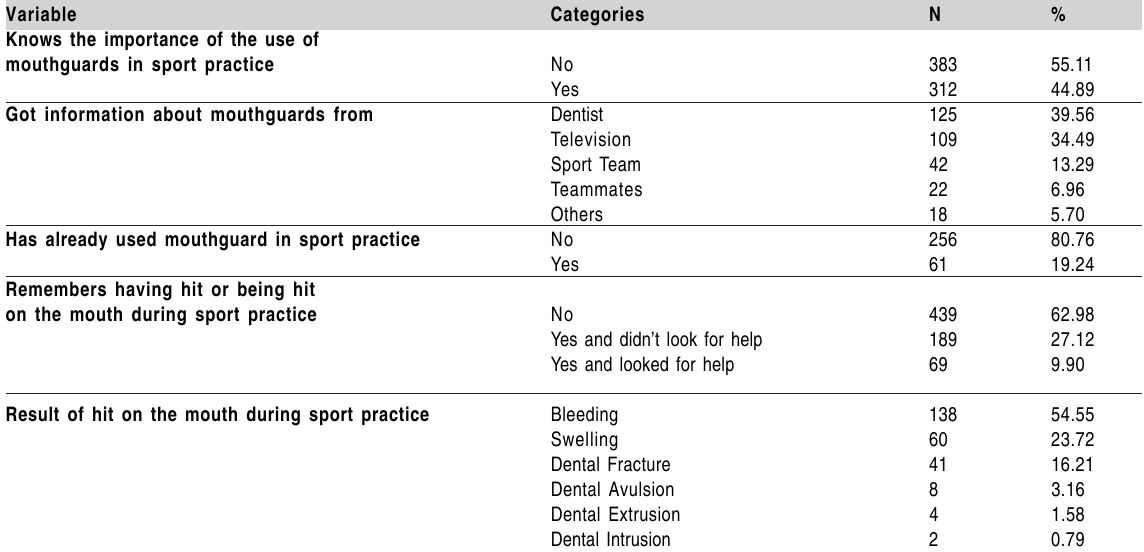
2005.showed a statistically significant association with the prevalence of orofacial injuries. Males showed 2.78 (2.00-5.24) more chances of having injuries than female. Sport practitioners had 3.45 more chances of being injuried (Table Table 2. Distribution of university students according to the use of mouthguards. Joaçaba, SC, Brazil,